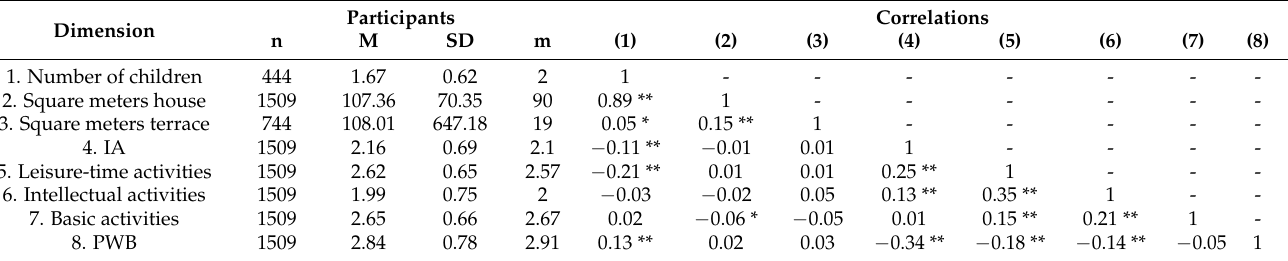
Table 1. Home conditions. Means (M), Standard Deviations (SD), Medians (m) and correlations (N = 1509). Dimension